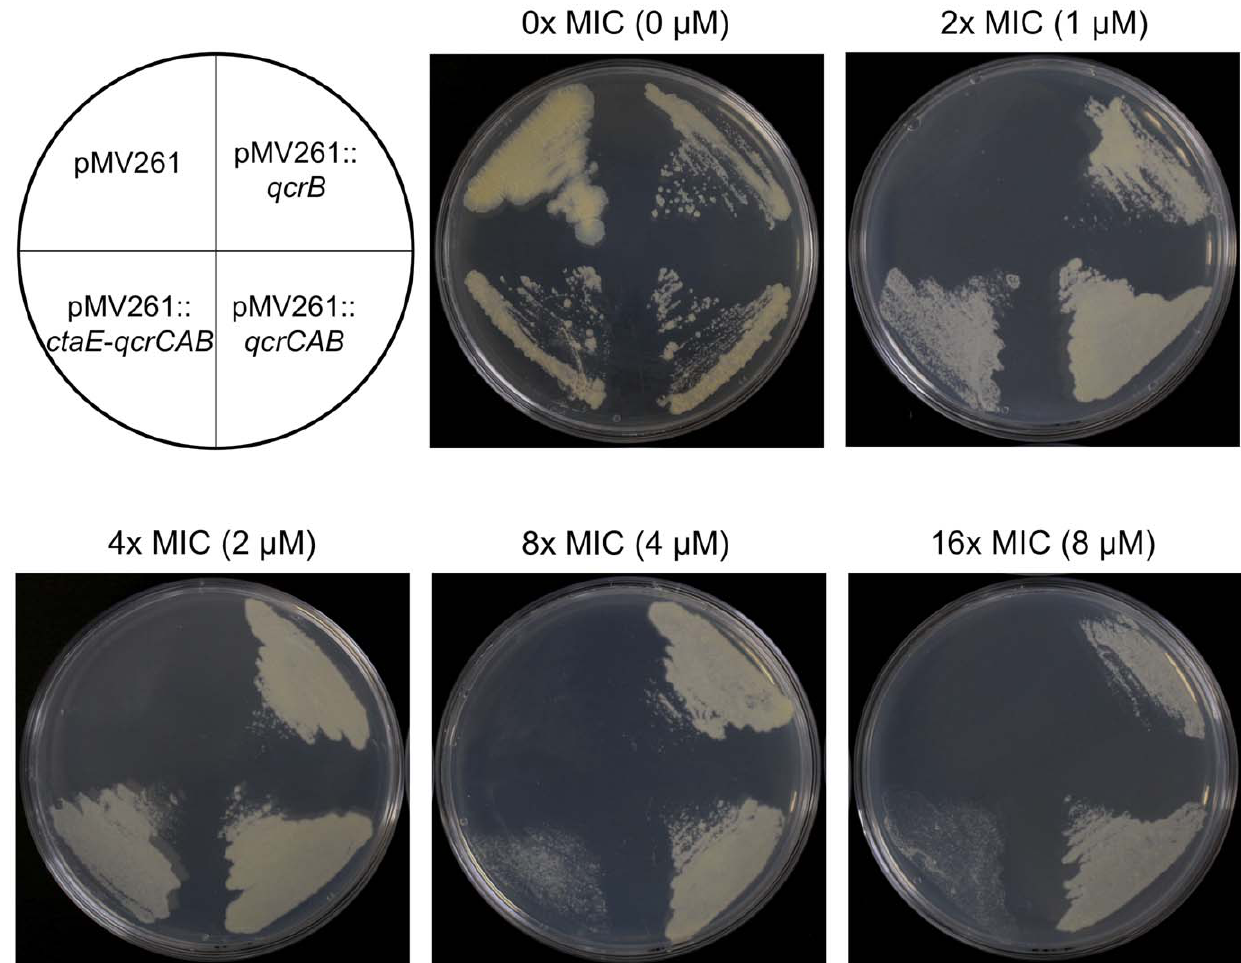
Figure 6. Effect on the MIC of IP 3 during the over-expression of QcrB in M.bovis BCG. The over-expression constructs pMV261, pMV261:: qcrB , pMV261:: qcrCAB and pMV261:: ctaE-qcrCAB were electroporated into M. bovis BCG and the MIC of IP 3 was evaluated. The plate lay-out is shown ( M. bovis BCG containing the construct detailed) and the MIC of IP 3 with reference to wild-type M. bovis BCG is stated along with the corresponding concentration analyzed. Kanamycin was present at 25 m g/ml to select for the pMV261